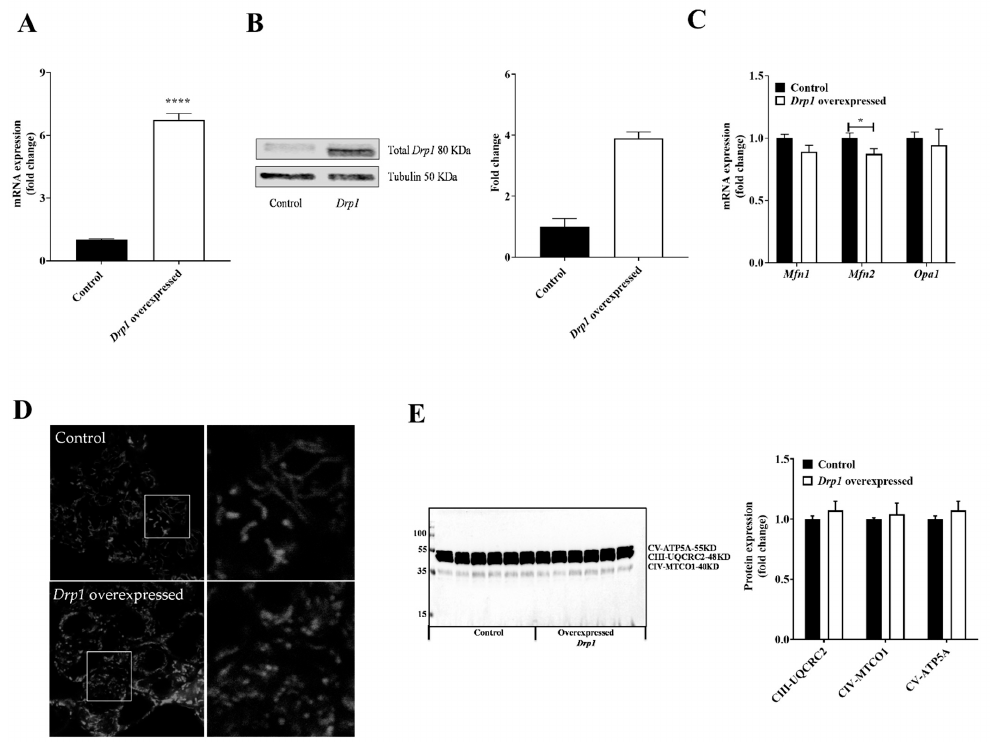
Figure 2. Alteration of mitochondrial morphology but not respiratory machinery by Drp1 overex- pression in MIN6 cells. MIN6 cells were transiently transfected using Drp1 plasmid by the electroporation technique to overexpress Drp1 : control (black bars) and overexpressed Drp1 (white bars). ( A ) The overexpression efficiency of Drp1 was confirmed by qPCR. HPRT was used as a control. ( B ) Representative immunoblot and densitometric quantification of Drp1 protein content. Tubulin was used as a loading control. ( C ) Relative levels of Mfn1 , Mfn2, and Opa1 mRNA were measured by qPCR, using HPRT as the housekeeper gene. ( D ) Live confocal imaging of transiently transfected MIN6 cells that were stained with MitoTracker Red FM for 30 min. Representative confocal images of the control and Drp1- overexpressed cells. ( E ) Immunoblot and densitometric quantification of OXPHOS complexes. Data are represented as mean ± SEM ( n = 6), and n -values represent independ- ent experiments. The statistical significance of mean differences was tested by an unpaired two- tailed Student’s t -test. p < 0.05 (*), p < 0.0001 (****).